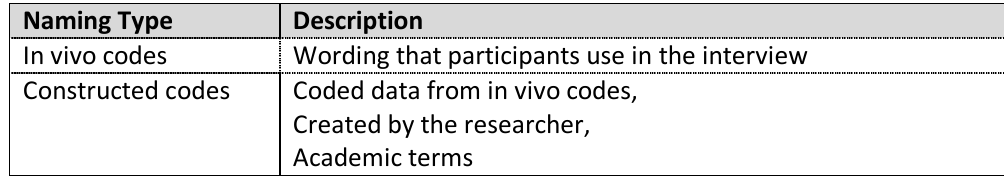
Table 1: Different naming strategy for